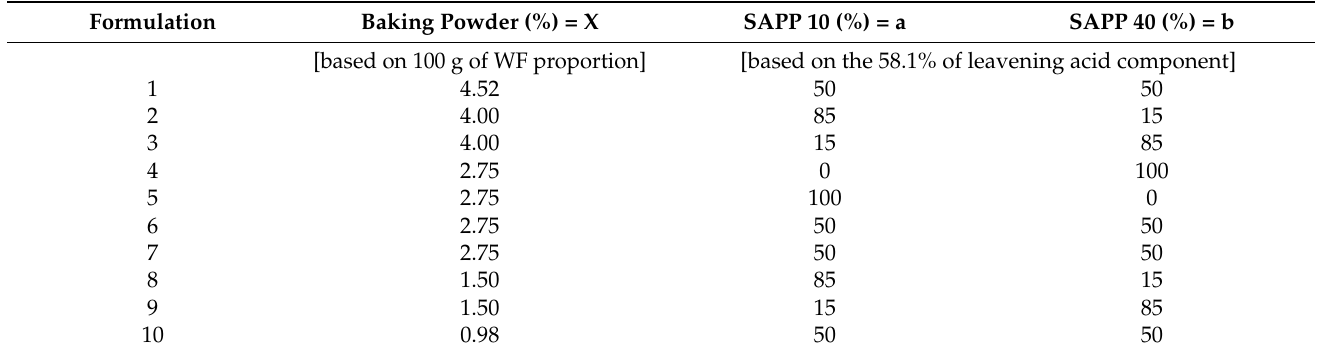
Table 2. Generated batter and cake formulations from the central composite design of RSM/experimental design of BP and SAPP’s for batter and pound cake